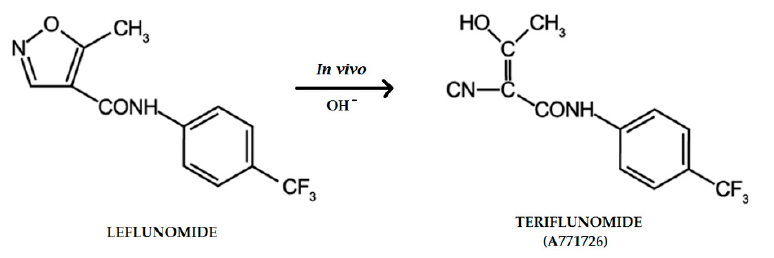
Figure 1. Chemical structures of leflunomide and its active metabolite—teriflunomide.